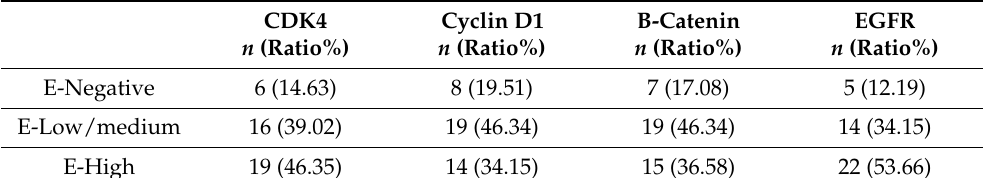
Table 2. Percentage of positive expression for CDK4, Cyclin-D1, B-catenin, and EGFR in pancreatic cancer, classified according to tissue expression levels. E-Negative = negative expression; E-Low/Medium = tissue expression classified as low/medium; E-High = tissue expression classified as high.